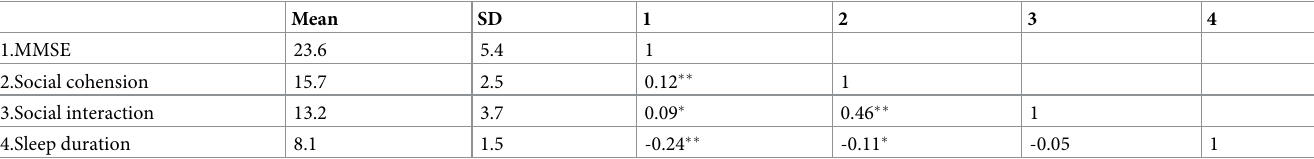
Table 2. Correlation matrix between SC, sleep duration, and MMSE score (n = 955) a